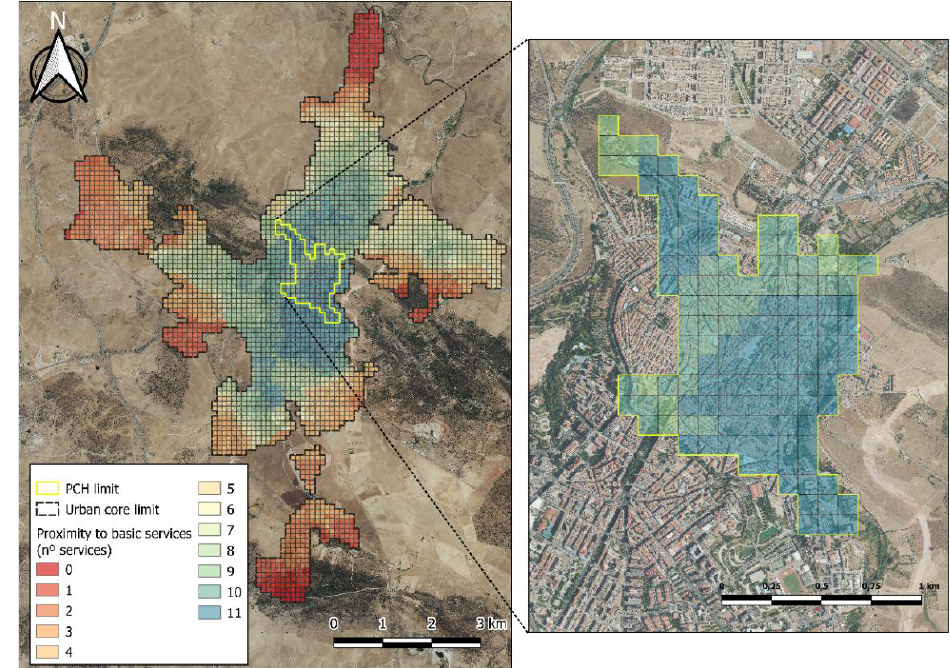
Figure 10. Proximity of population to basic services comparison.